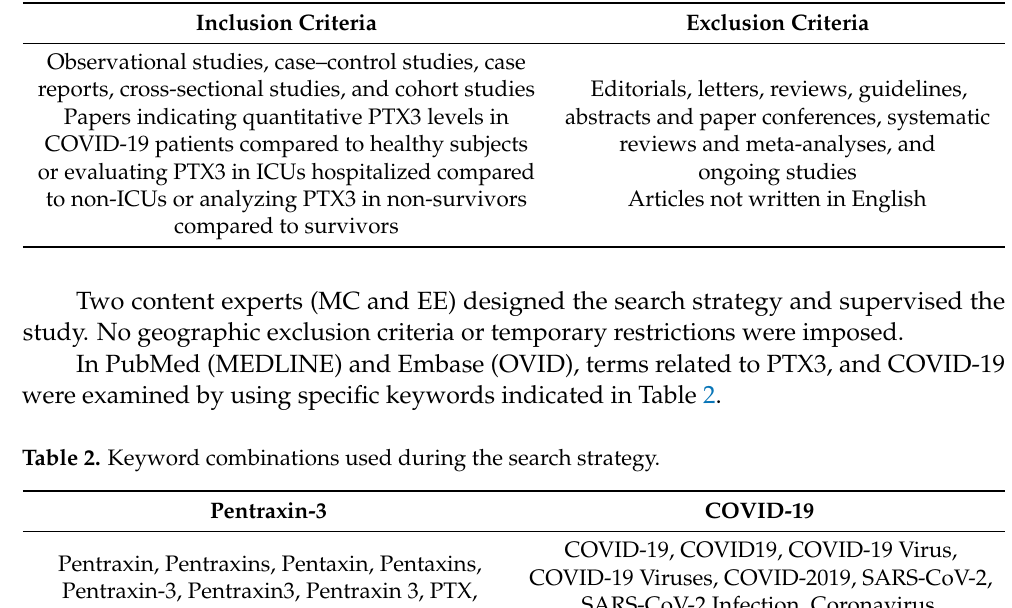
Table 1. Description of eligibility criteria.